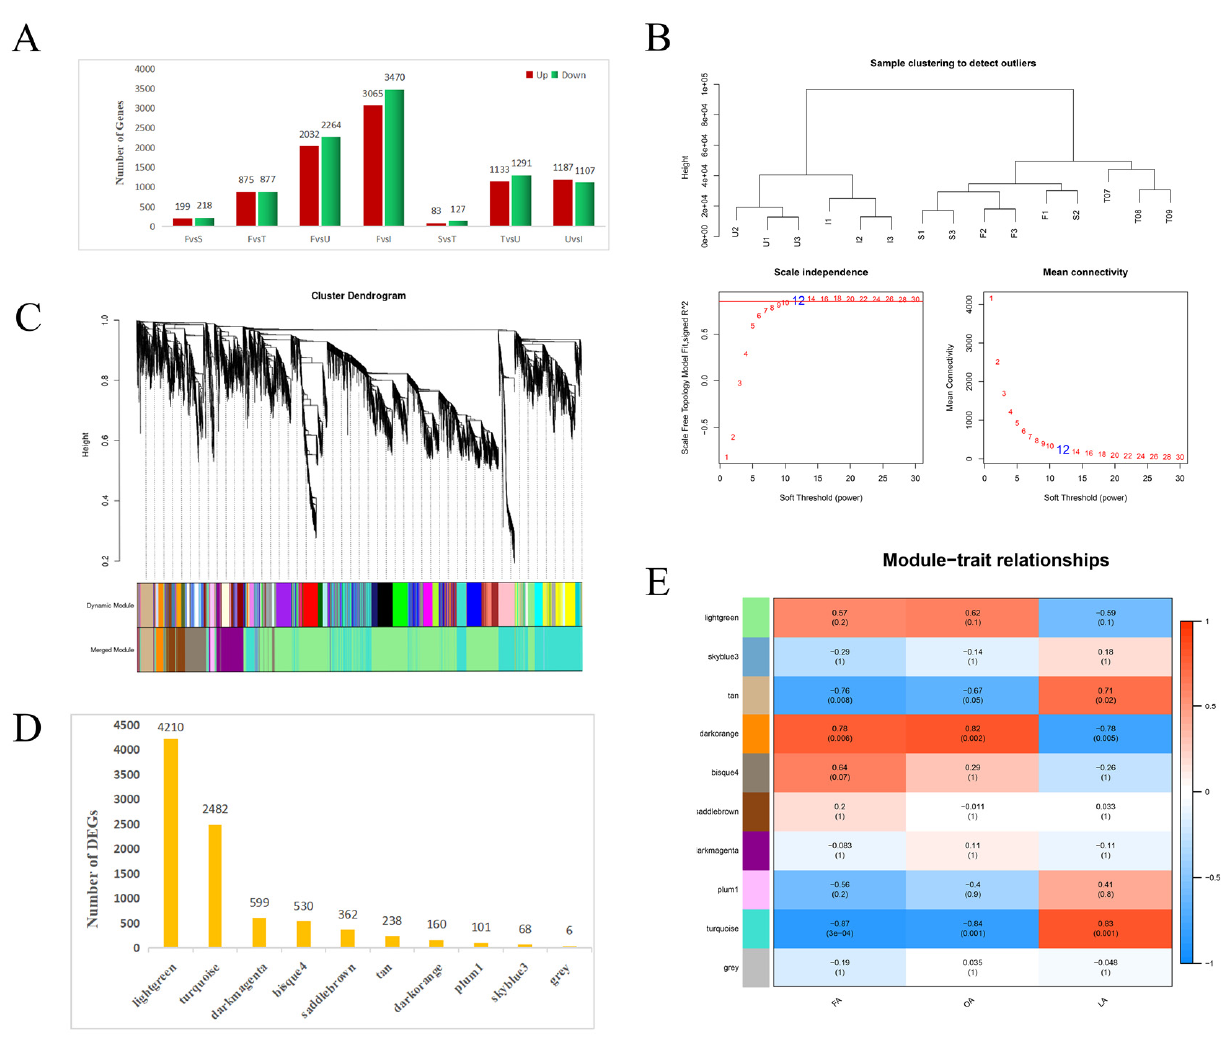
Figure 2. WGCNA of DEGs. ( A ) DEGs identified by pairwise comparison between samples at each time point. ( B ) Power of the WGCNA. ( C ) WGCNA cluster dendrogram. ( D ) DEG number in each module. ( E ) Correlation of the expression patterns of the modules to physiological traits.